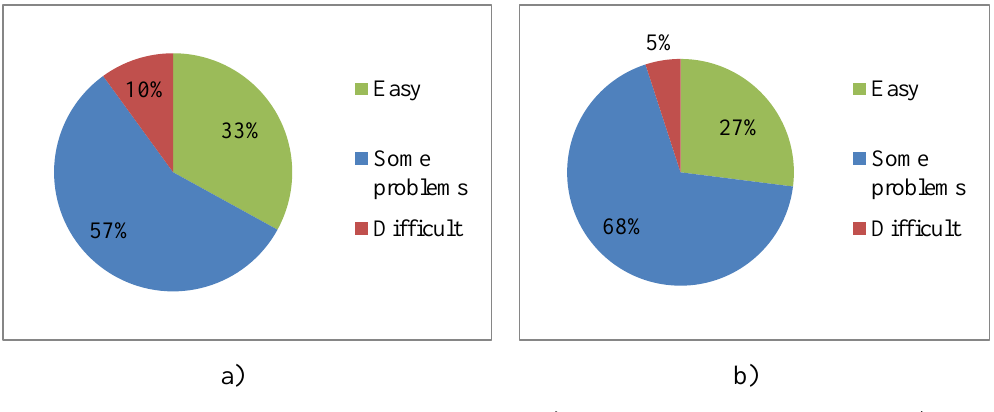
Fig. 4. Assessment of PBL by students: a) workshop in Southampton;